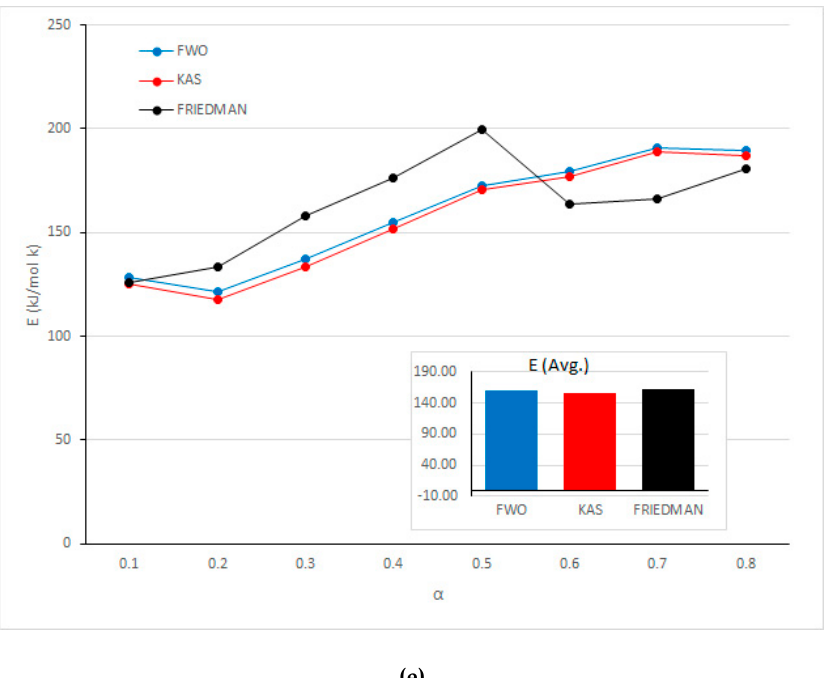
Figure 4. Comparison of activation energy values ( E, kJ/mol) vs. conversion ration obtained by different isoconversional model methods. ( a ) sponge foam, ( b ) plastic, ( c ) rubber, ( d ) fiber, ( e ) mixed sample.